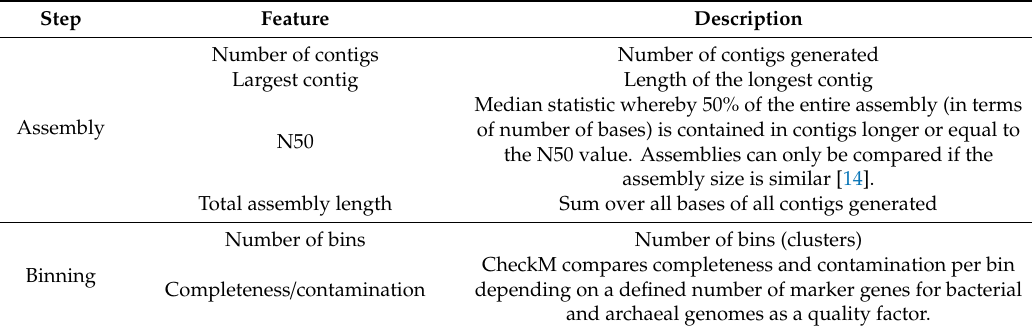
Table 3. Quality characteristics to compare tool